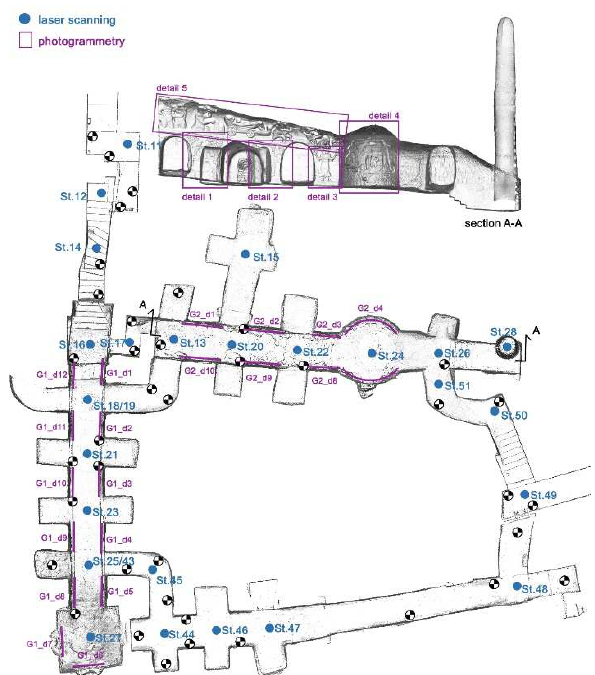
Figure 5: Plan and section of the surveyed galleries with location of TLS stations, targets and photogrammetric